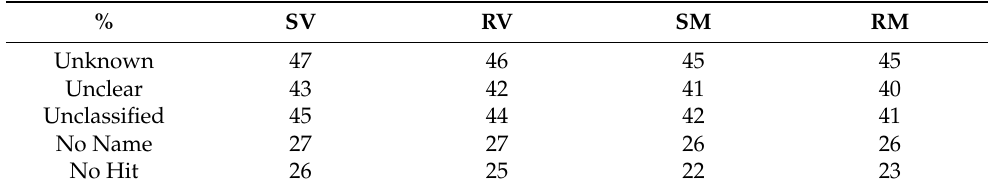
Table 2. Functional profiling of the expression of all non-annotated transcript categories for each RNA-Seq library according to each transcript functional category. The number of transcripts (length ≥ 150 and RPKM ≥ 1) per functional category was divided by the total transcripts from that category in order to normalize the expression profiles according to the number of transcripts on each class. SV: SDI v é raison ; RV: RDI v é raison ; SM: SDI full maturation; RM: RDI full maturation.